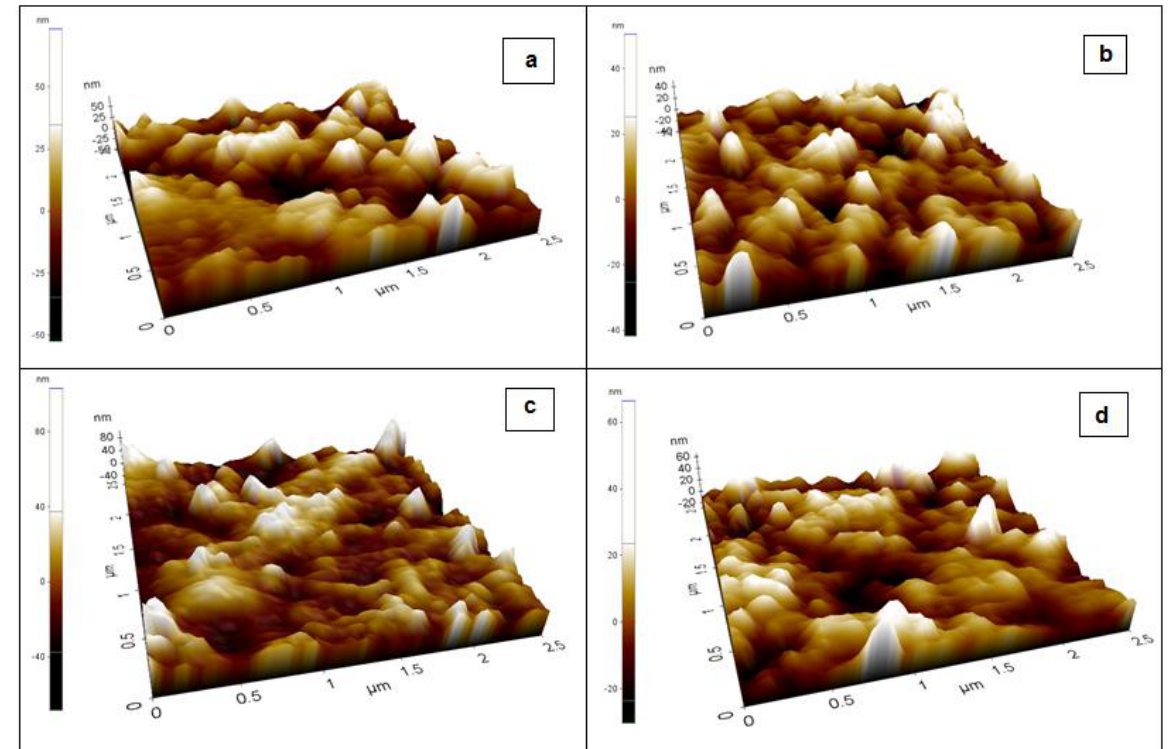
Figure 9. Image showing the 3-D surface roughness of the PVA/PPy/KI/I 2 electrolyte with various plasticizers (in wt.%); ( a ) EC, ( b ) PC, ( c ) GBL, and ( d ) DBP.